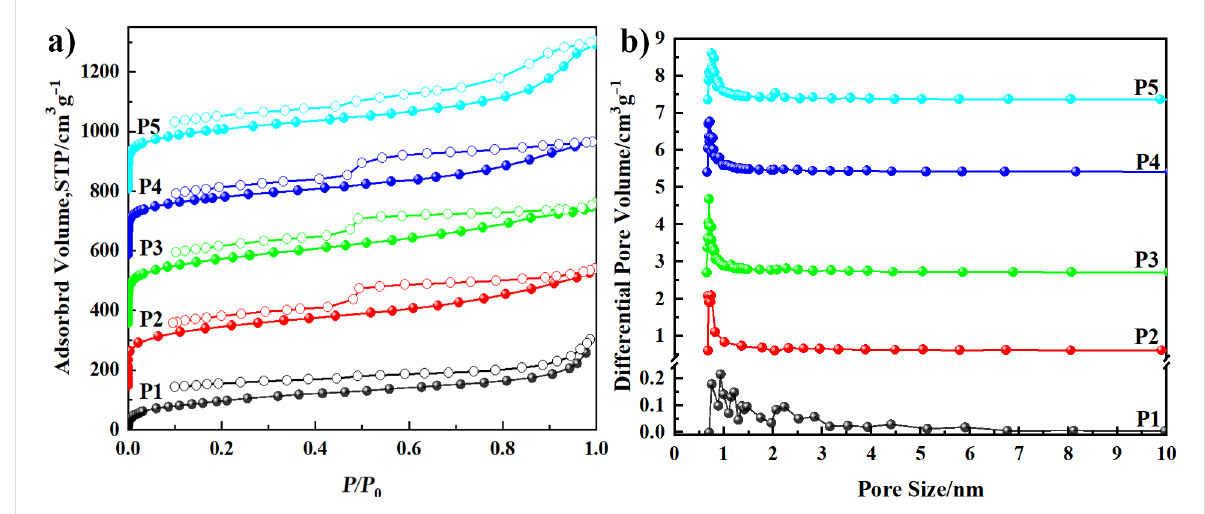
Figure 6: Nitrogen sorption isotherms (a) and pore size distribution (b) of P1 – P5 .